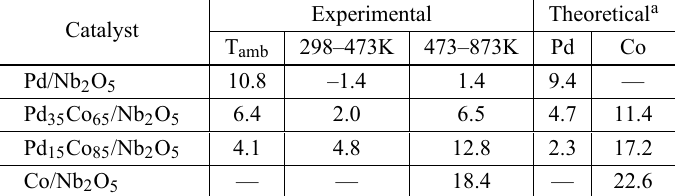
TPR hydrogen uptakes for bimetallic catalysts (Noronha et al. 2000b). Experimental Catalyst